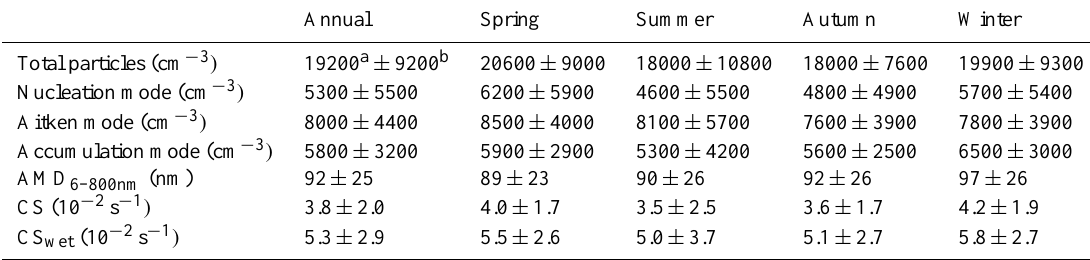
Table 1. Overall statistics for the number concentrations and relevant parameters calculated based on DMPS measurement at the SORPES site during December 2011–November 2013. Annual Spring Summer Autumn Winter